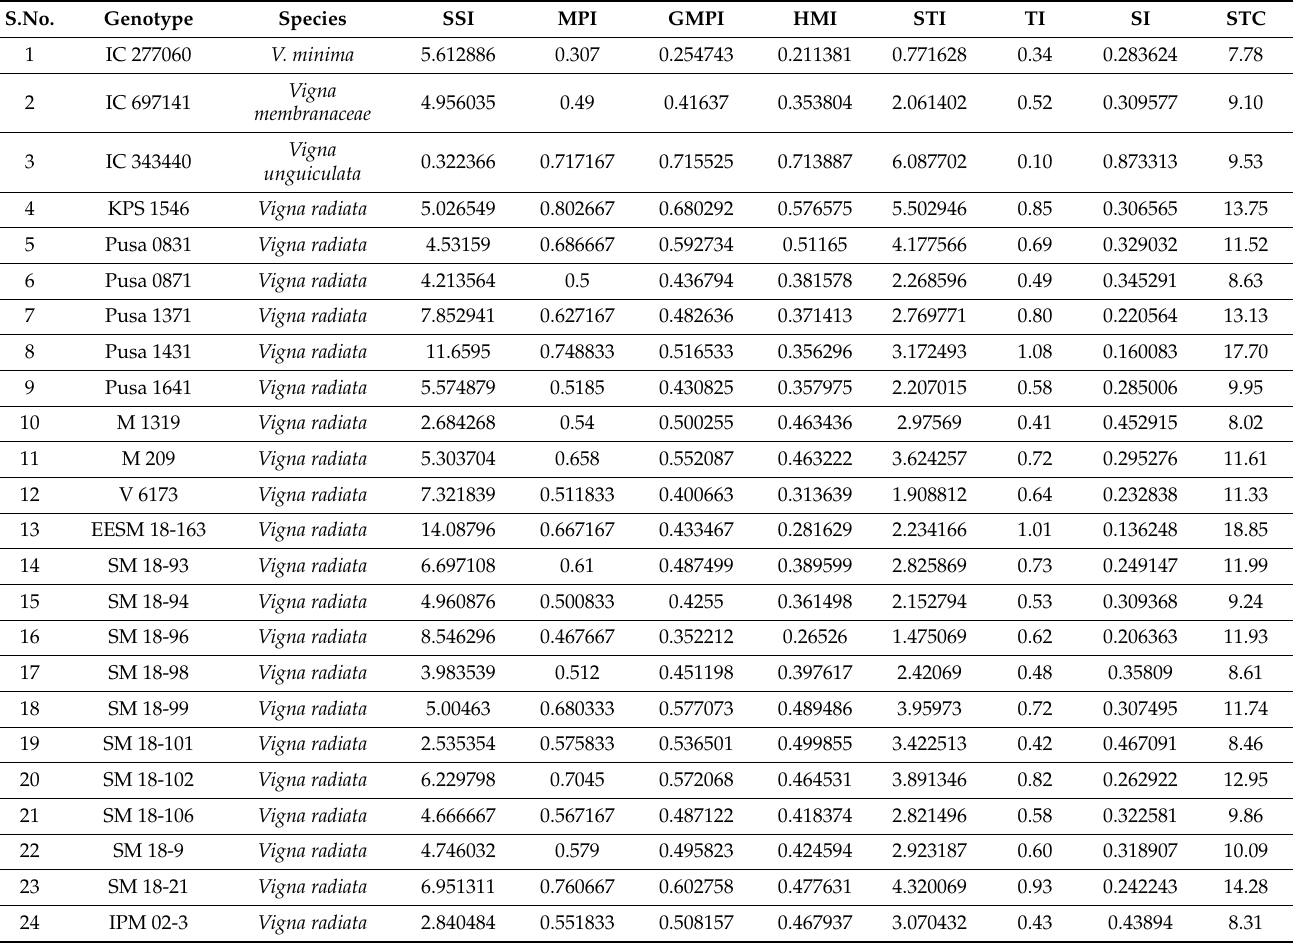
Table 6. Phosphorus deficiency tolerance indices of promising genotypes identified under optimum- and low-phosphorus conditions